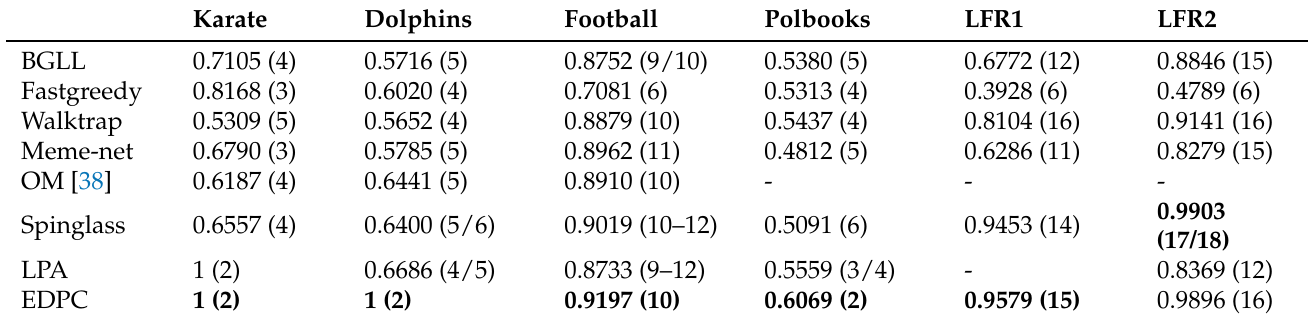
Table 3. Results of NMI and the number of communities on networks.